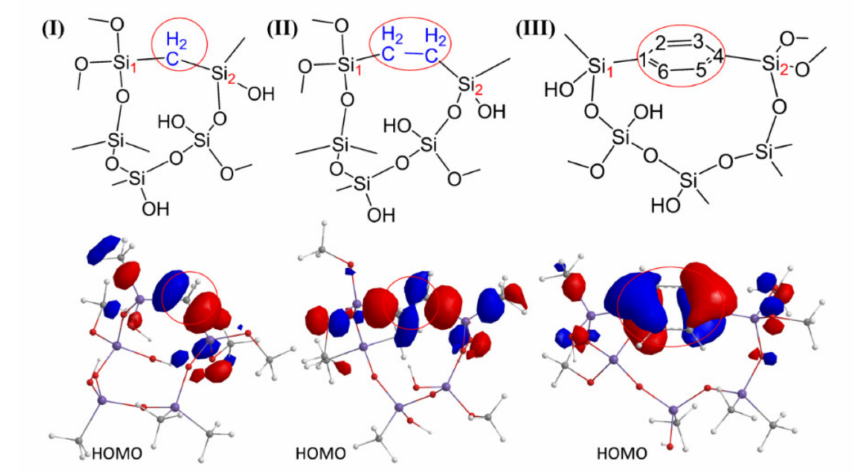
Figure 13. Structures of model polymers with ( I ) methylene-, ( II ) ethylene- and ( III ) 1,4-Ar bridges (Ar is aryl) used for calculations, and electron distribution of the highest occupied molecular orbital (HOMO) responsible for the reactivity of the model